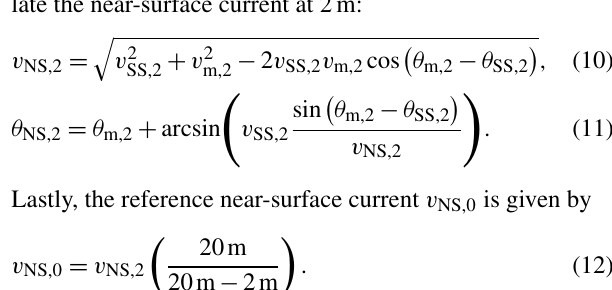
of 2m (measured values (m), near- and sub-surface components (NS and